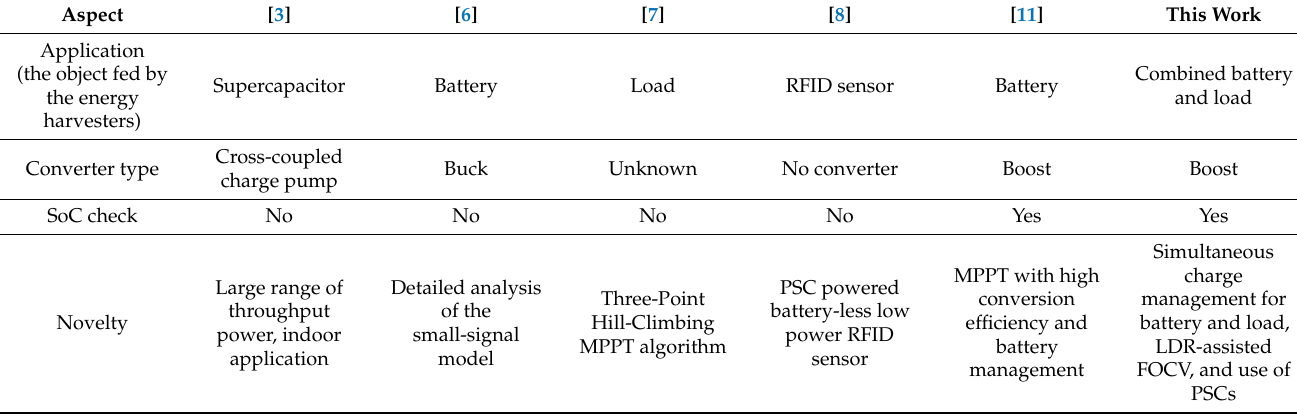
Table 1. Comparison of the literature and this